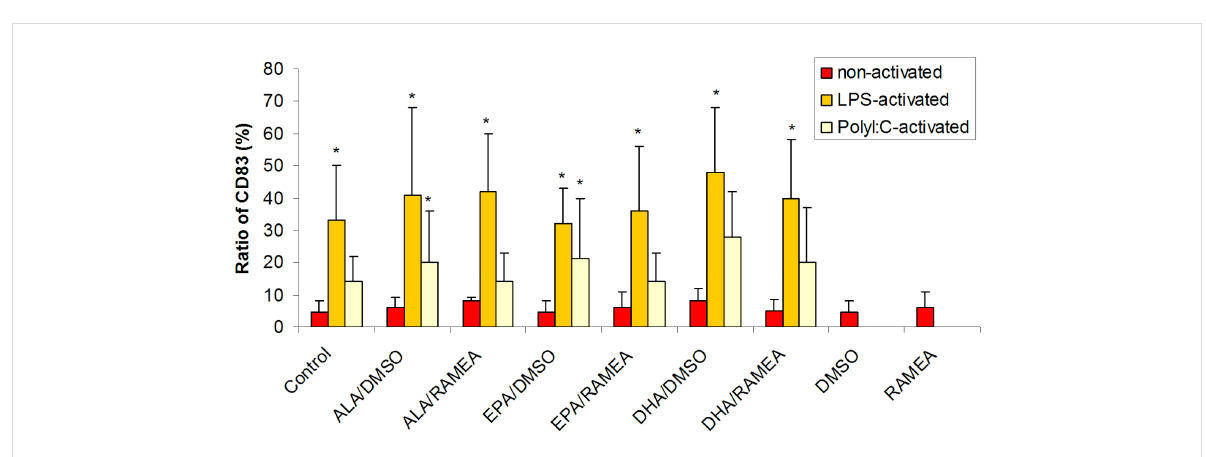
Figure 5: Effect of n − 3 PUFAs on the expression of the CD83 activation marker in resting (red), LPS-activated (yellow) and Poly(I:C)-activated (white) moDC ( N = 6) (* p < 0.05 compared to the